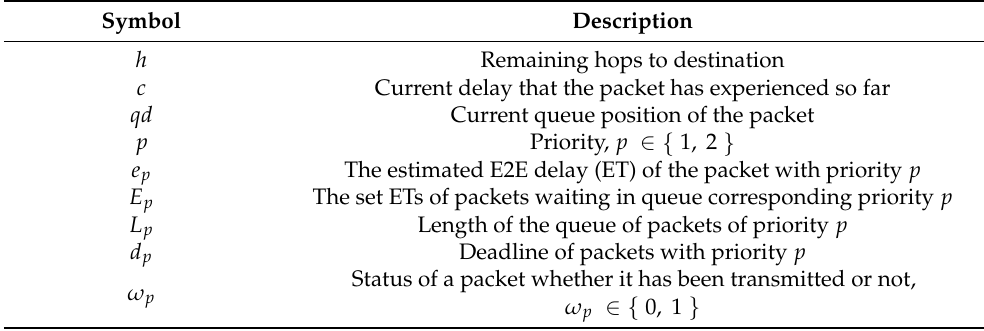
Table 3. Symbols used in state, action, and reward